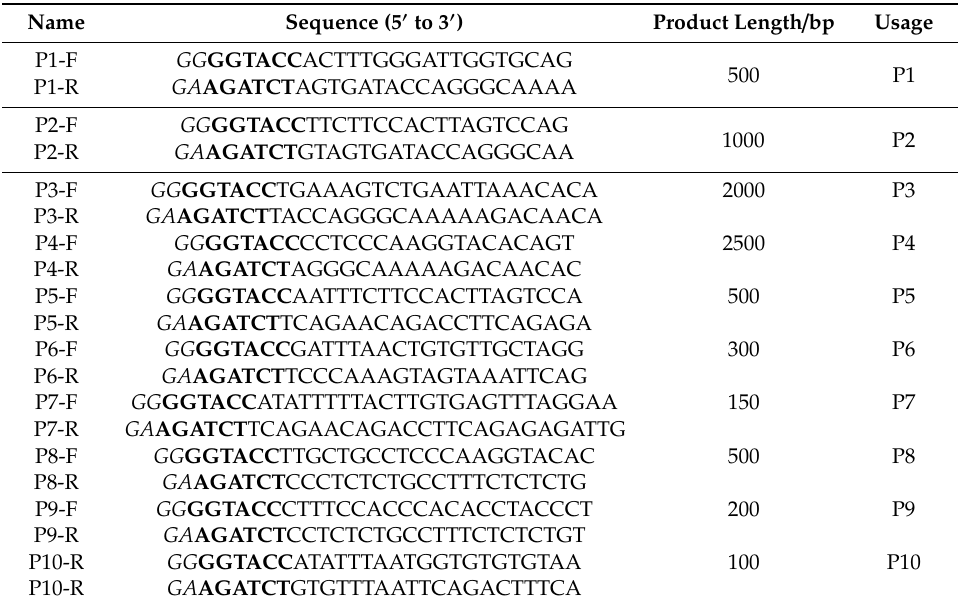
Table 4. Primers used for construction of Slc7a11 promoter deletion